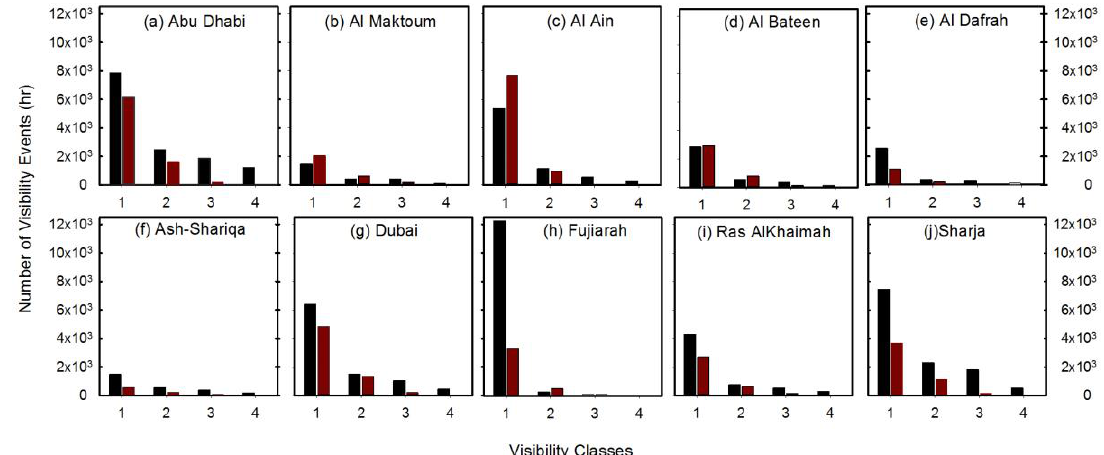
Figure 8. Frequency analysis of wet and dry visibility events in all stations: ( a ) Abu Dhaib; ( b ) Al Maktoum; ( c ) Al Ain; ( d ) Al Bateen; ( e ) AL Dafrah; ( f ) Ash-Shariqa; ( g ) Dubai; ( h ) Fujairah; ( i ) Ras Al-Khaimah; and ( j ) Sharjah. With visibility caused by wet conditions in Back, and visibility caused by dry weather conditions in Red. For four visibility classes: 1 (5–2.5 km), 2 (2.5–1.0 km), 3 (1.0–0.1 km), and 4 (<0.1 km).